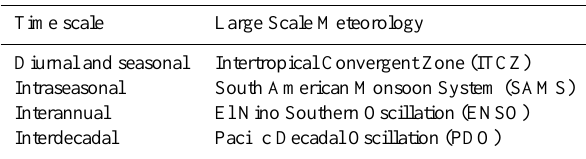
Table 1. Large-scale meteorological phenomena and timescales, adapted from Carvalho et al.